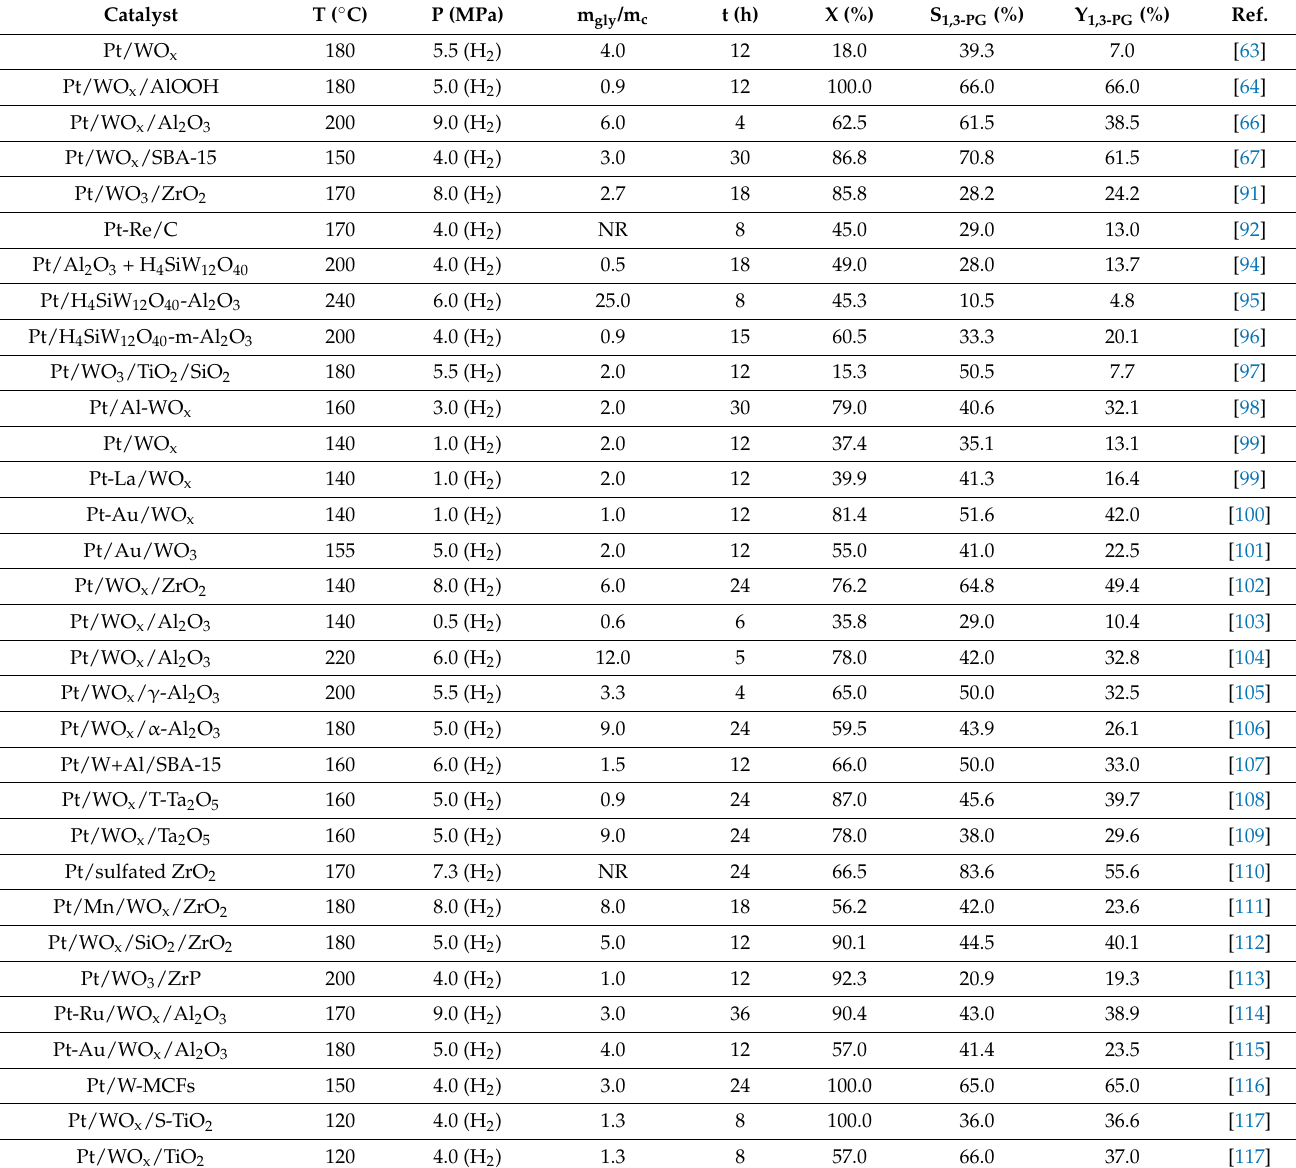
Table 4. The hydrogenolysis of glycerol to 1,3-PG using Pt catalysts operating in liquid phase batch